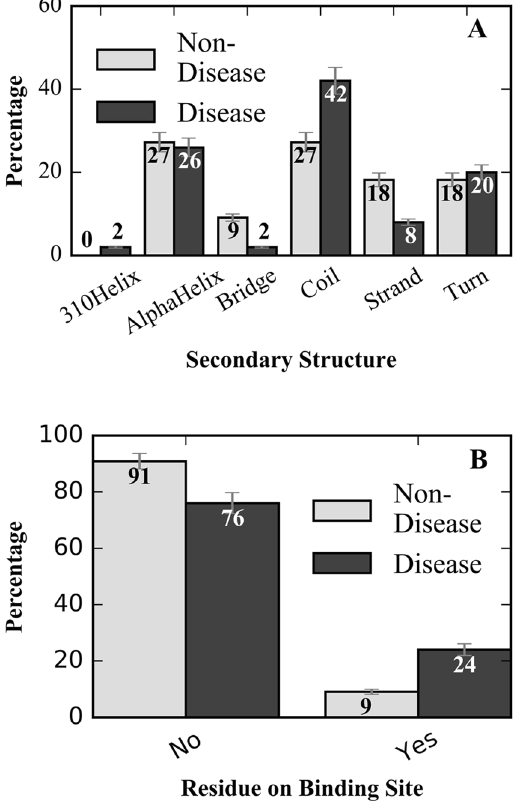
Figure 5. Location of the mutation is correlated to its likelihood of causing disease. ( A ) Histograms indicating which secondary structure the mutated residue is on for disease-causing and non-disease-causing mutants. ( B ) Histograms indicating whether the mutated residue is on the microtubule binding interface or not for disease- causing and non-disease-causing